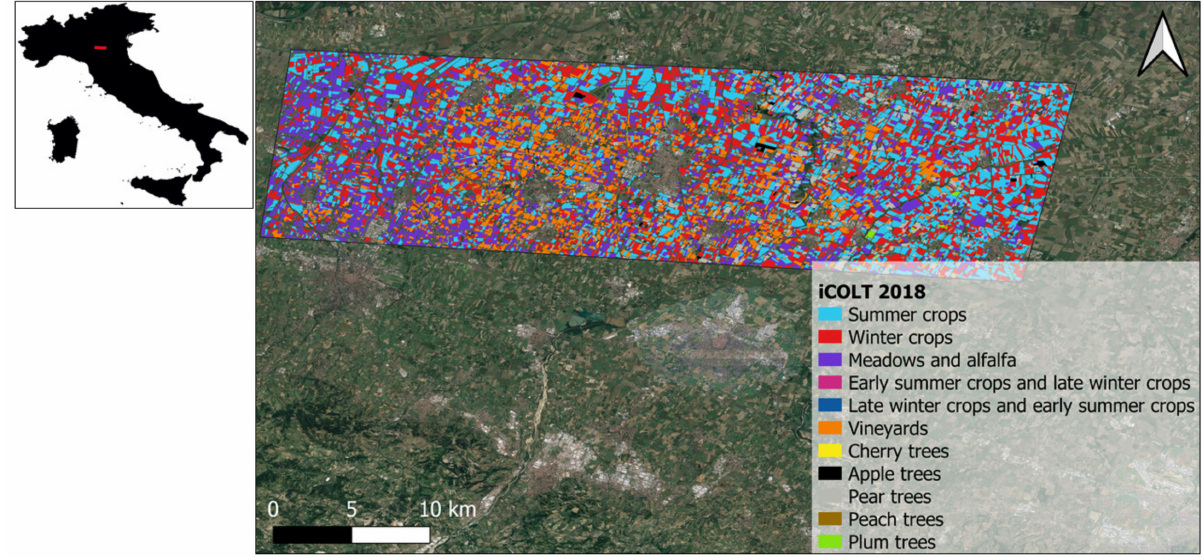
Figure 2. Italian test site (located in the Emilia Romagna region) and crop map referring to the year 2018 derived by the iColt